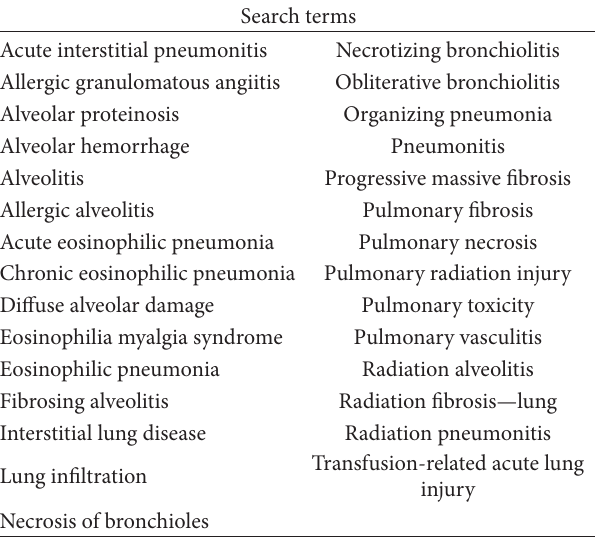
Table 1: Standardized MedDRA query terms for identifying poten- tial cases of ILD from clinical and safety